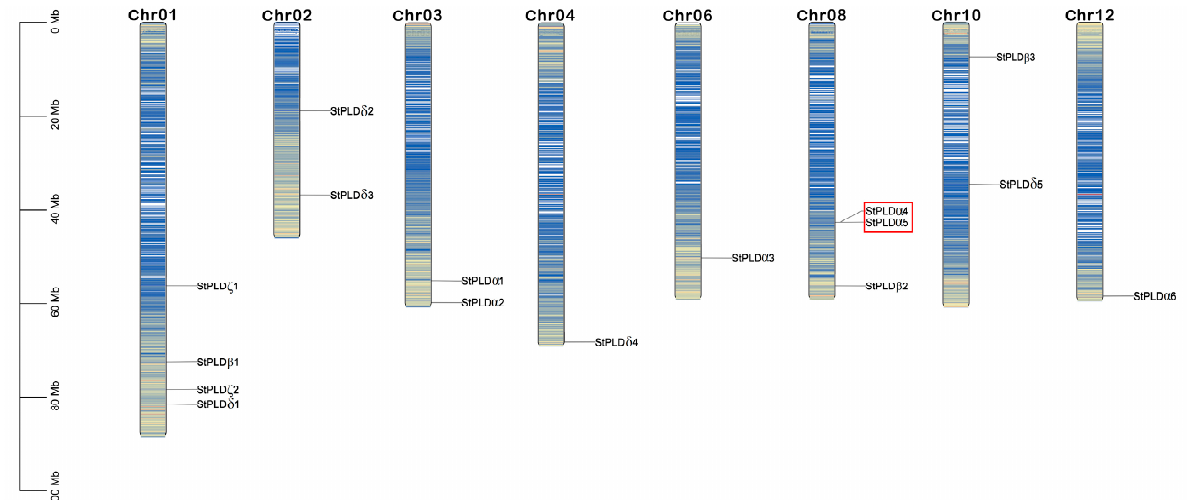
Figure 3. Chromosomal distribution of Potato PLD genes. Red box indicates tandem duplicate genes. Blue lines on chromosomes indicate gene density.